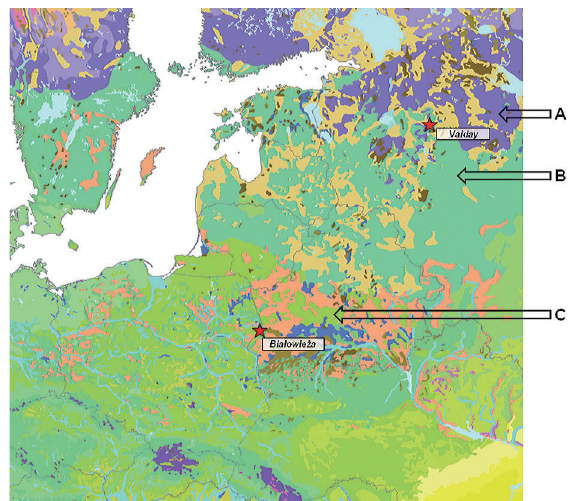
Fig. 1. Location of the studied forest complexes: Białowieża Forest and Valday National Park on the Map of the Natural Vegetation of Europe (2004) A – Southern boreal coniferous and mixed broad-leaved-coniferous forests; Scandinavian-east European spruce forests partly with Tilia cordata and Corylus avellana , with herbs, dwarf shrubs and mosses. B – Hemiboreal spruce forests with broad-leaved trees; Baltic-north- west Sarmatian herb-rich mixed broad-leaved-spruce forests ( Picea abies , Tilia cordata , Acer platanoides , Quercus robur ) with Corylus avella - na , Euonymus verrucosa , Galeobdolon luteum , Stellaria holostea . C – Mesophytic deciduous broad-leaved and mixed conifer- ous-broad-leaved forests; Mixed oak-hornbeam forests ( Carpinus betulus , Quercus robur , Q. petraea , Tilia cordata